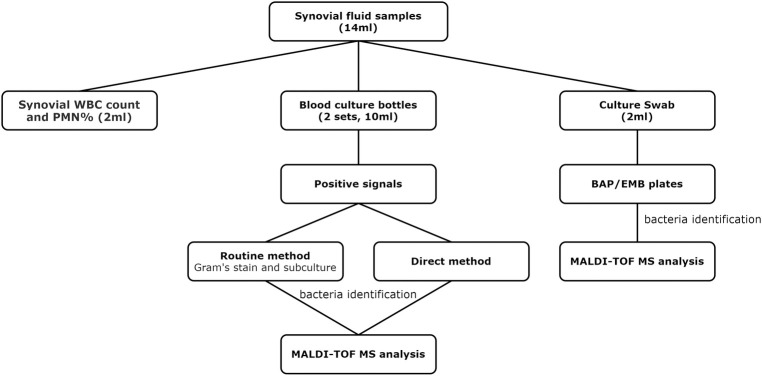
Schematic representation of the diagnostic workflow.